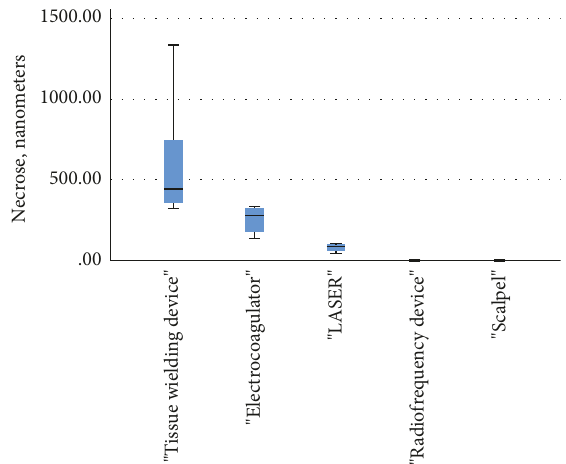
Figure 4: The width of spleen necrosis after the use of various surgical devices on day 0. Table 4: Difference in rabbit respiratory rate between skin and spleen incision(breaths per minute). Surgical